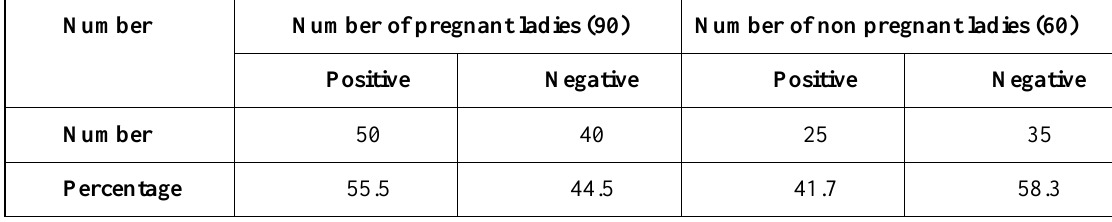
Table 1. Percentage of isolated Candida among pregnant and non-pregnant women.